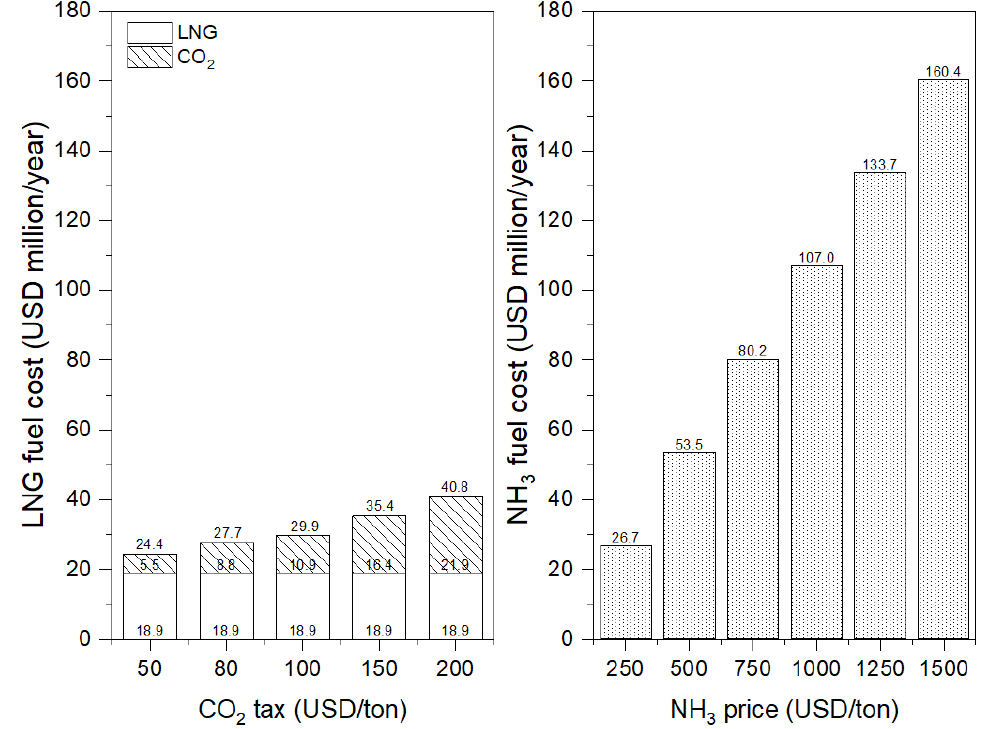
Figure 10. LNG and NH 3 fuel cost for the carbon tax and NH 3 price.